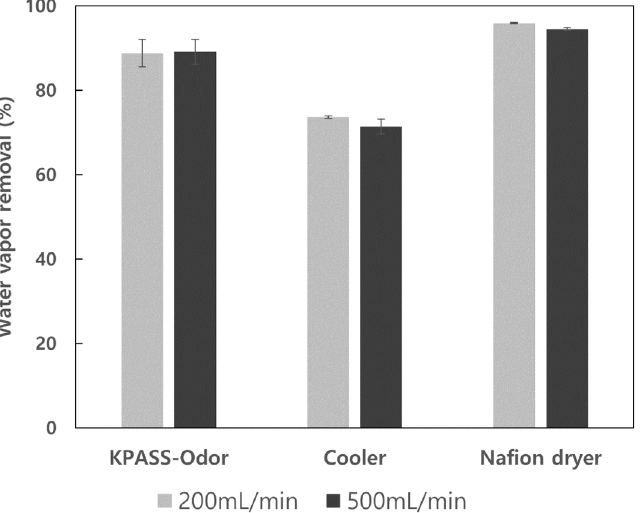
Figure 5. Comparison of the moisture removal efficiency of different moisture pretreatment devices.